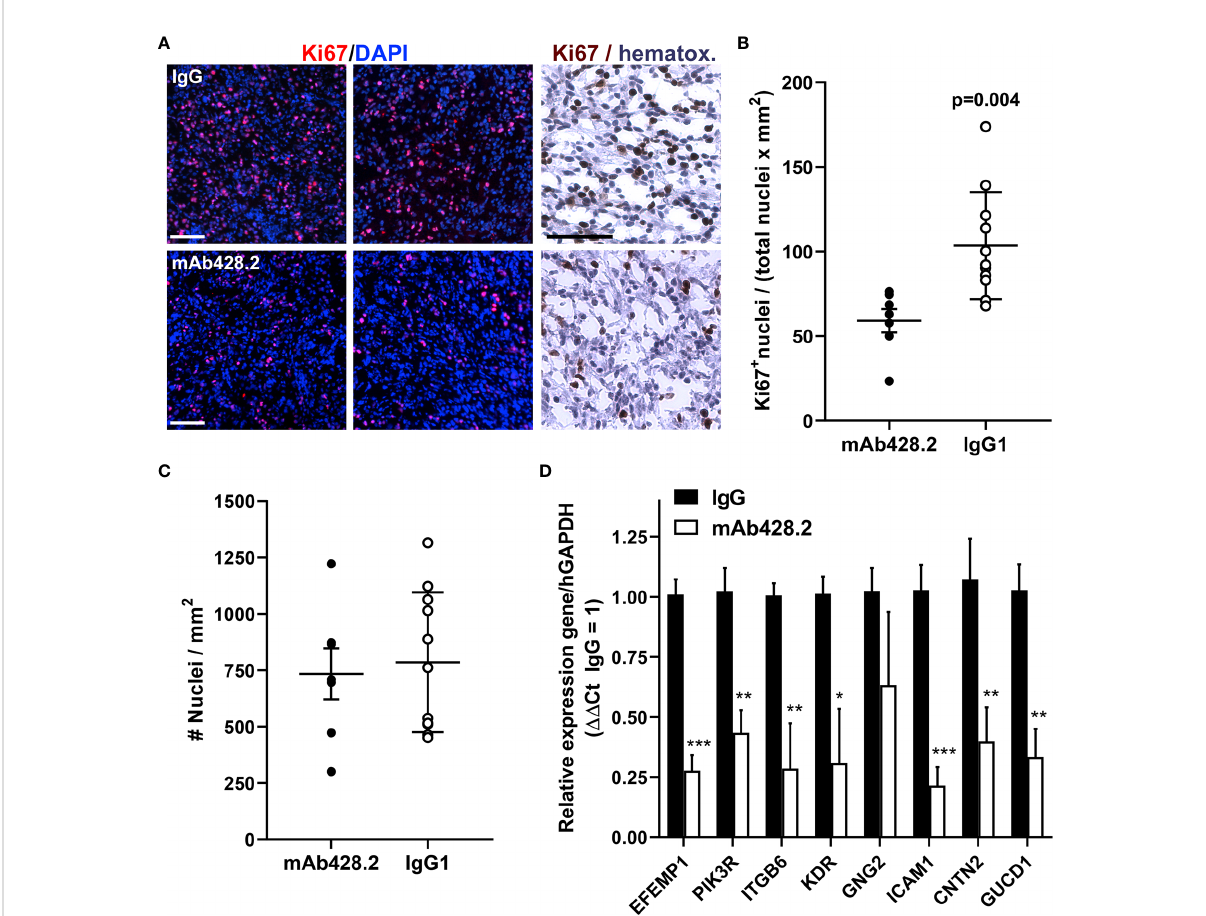
FIGURE 6 Anti- fi bulin-3 antibody reduces tumor cell proliferation in vivo. (A) Representative images of intrapleural tumors (H226 cells) from mice euthanized one week after fi nishing antibody treatments. Ki67 expression is shown by immuno fl uorescence (counterstained with DAPI) and conventional DAB immunohistochemistry (counterstained with hematoxylin) at higher magni fi cation. Notice the reduced Ki67 staining in mAb428.2-treated mice (bars= 100 µm). (B) Quantitative analysis of Ki67 immuno fl uorescent staining in intrapleural H226 tumors (N=5 mice/ treatment, 3 sections/mouse); signi fi cant differences determined by Student ’ s t-test. (C) Internal control con fi rming that the tissues analyzed had comparable density of nuclei per area (average tumor area for imaging was 26.4 ± 8.5 mm2 and 28.4 ± 11.9 mm2 for IgG and mAb428.2 treatments, respectively). (D) Analysis of tumor tissue by qRT-PCR using human-speci fi c primers; mAb428.2 treatment resulted in signi fi cant decrease in the expression of fi bulin-3 ( EFEMP1 ) and a subset of PI3K/Akt-regulated genes ( * p<0.05; ** p<0.01; *** p< 0.001 as determined by mixed-effects analysis with false discovery rate (FDR>5%)